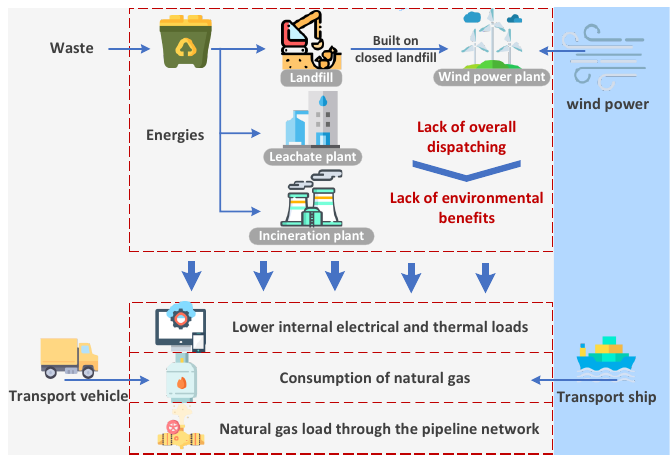
Figure 4. Initial overview of the waste processing base (WPB).